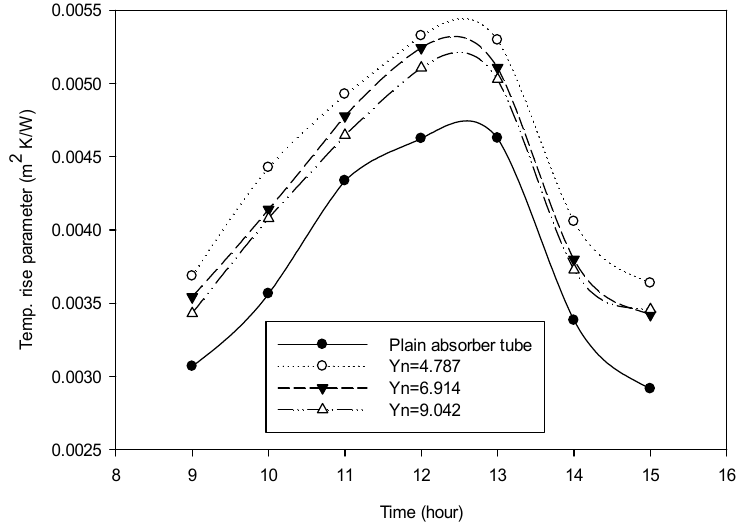
Figure 11. Variation in the temperature rise parameter with time and nail twist pitch ratio.